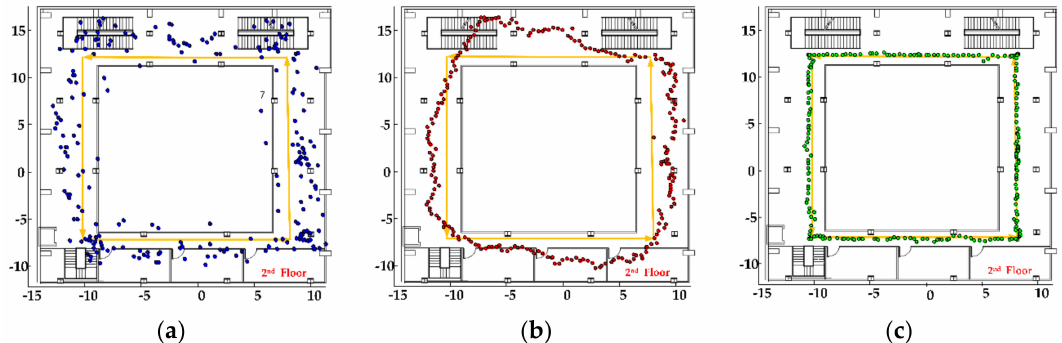
Figure 13. Positioning results in test environment 2: ( a ) CNN fingerprint positioning results, ( b ) PF fusion positioning results, and ( c ) PF fusion MEMS + MAP positioning results.